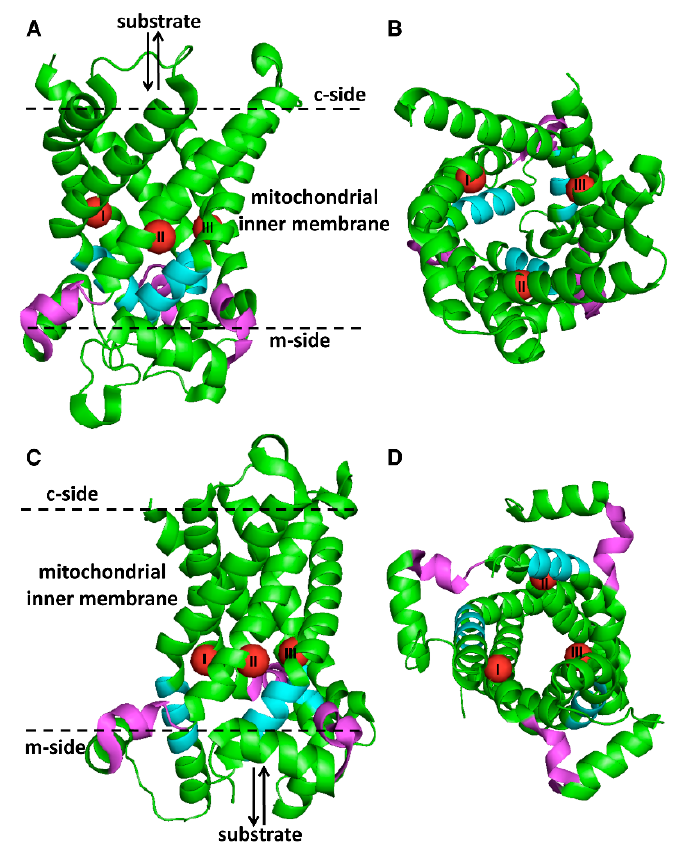
Figure 1. Structures of AAC. The carboxytractyloside-inhibited bovine AAC (PDB ID 1OKC) ( A , B ) and a bongkrekic acid-inhibited AAC of Thermothelomyces thermophila (PDB ID 6GCI) ( C , D ) are viewed laterally in the plane of the inner mitochondrial membrane ( A , C ), and from the c- ( B ) and m-sides ( D ). The first and second parts of the signature motif sequence are colored in cyan and magenta, respectively. Contact points I–III are shown as red spheres.